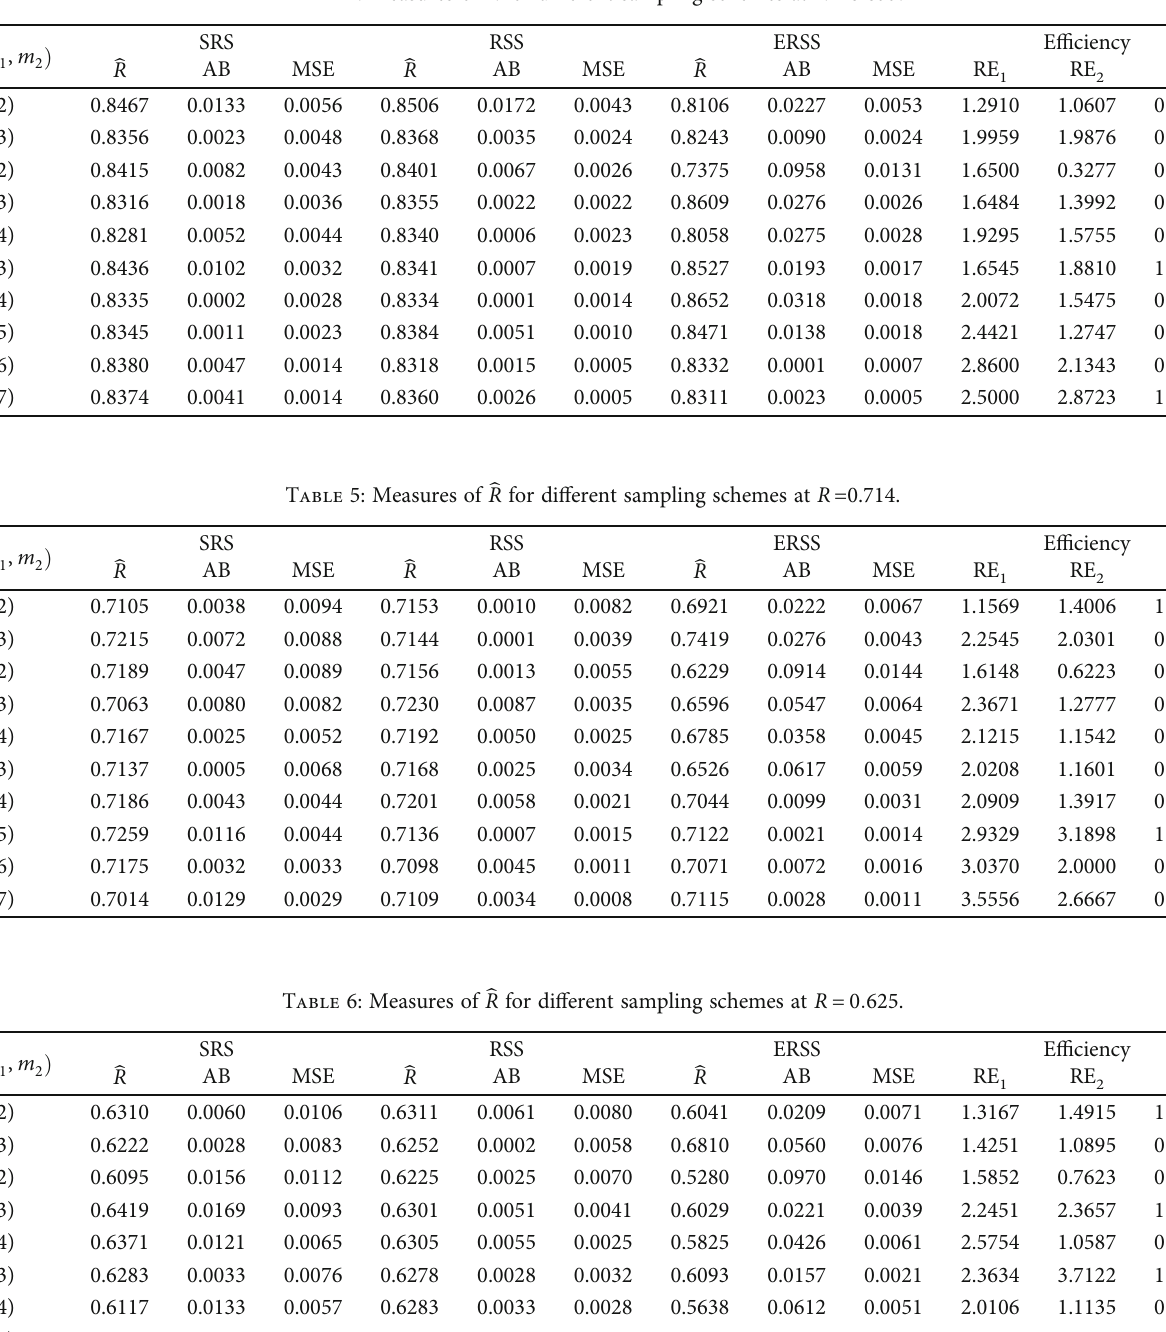
Table 4: Measures of ̂ R for di ff erent sampling schemes at R = 0 : 833